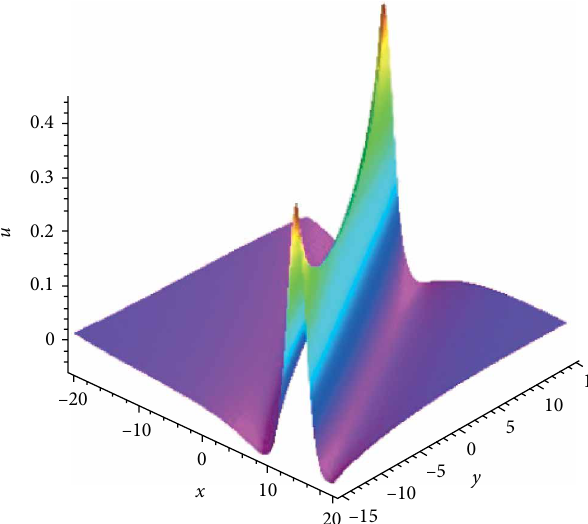
and 퐹 1 (푡) = 0, 훽(푡) = 퐹 2 (푡) = 푡,푘 = 2,푞 = −1, 휉 0 = 휁 0 = 푅 0 = 0 푡 = 0